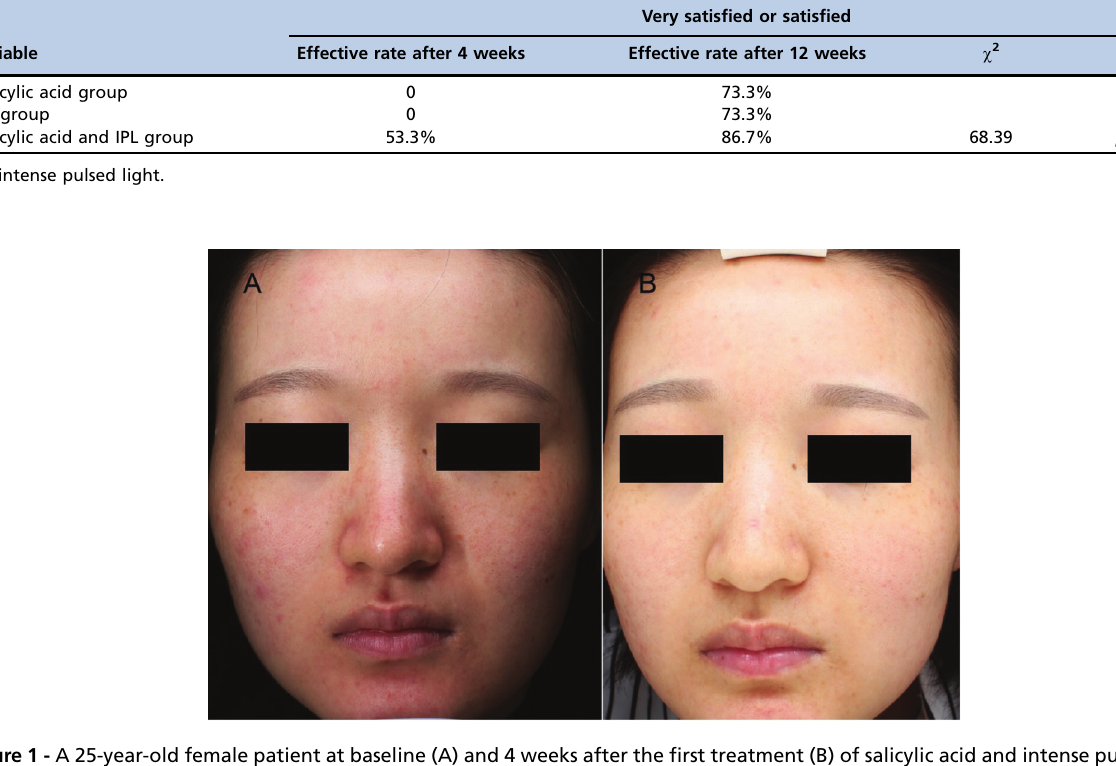
Table 2 - Effective rate after treatment of each